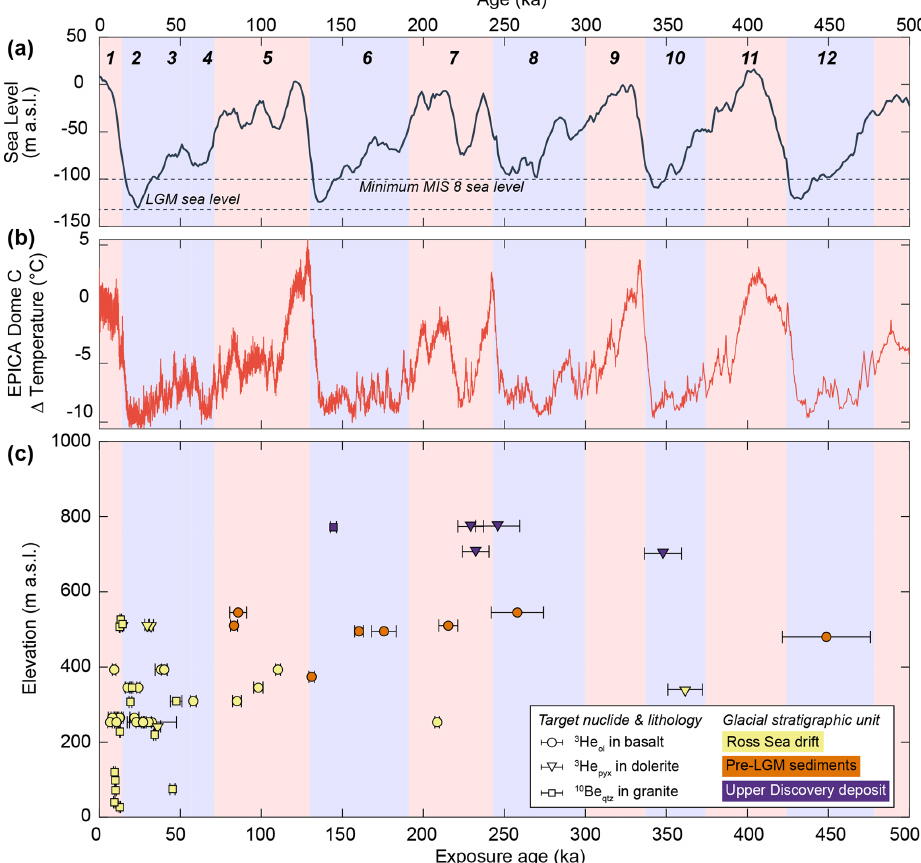
Figure 5. Exposure ages of McMurdo Sound glacial deposits in the context of paleoclimate since 500ka. (a) Marine Isotope Stage boundaries showing interglacial (light red) and glacial (light blue) periods, and global mean sea level (Spratt and Lisiecki, 2016) – dashed blue lines show minimum global sea level during the LGM and MIS 8. (b) Temperature difference from modern in the EPICA Dome C ice core in East Antarctica (Jouzel et al., 2007). (c) Exposure ages ( ± 1 σ error) of Ross Sea drift (yellow circles) and older pre-LGM deposits (orange circles), and the Upper Discovery deposit (purple). Shapes correspond to target nuclide and lithology of each